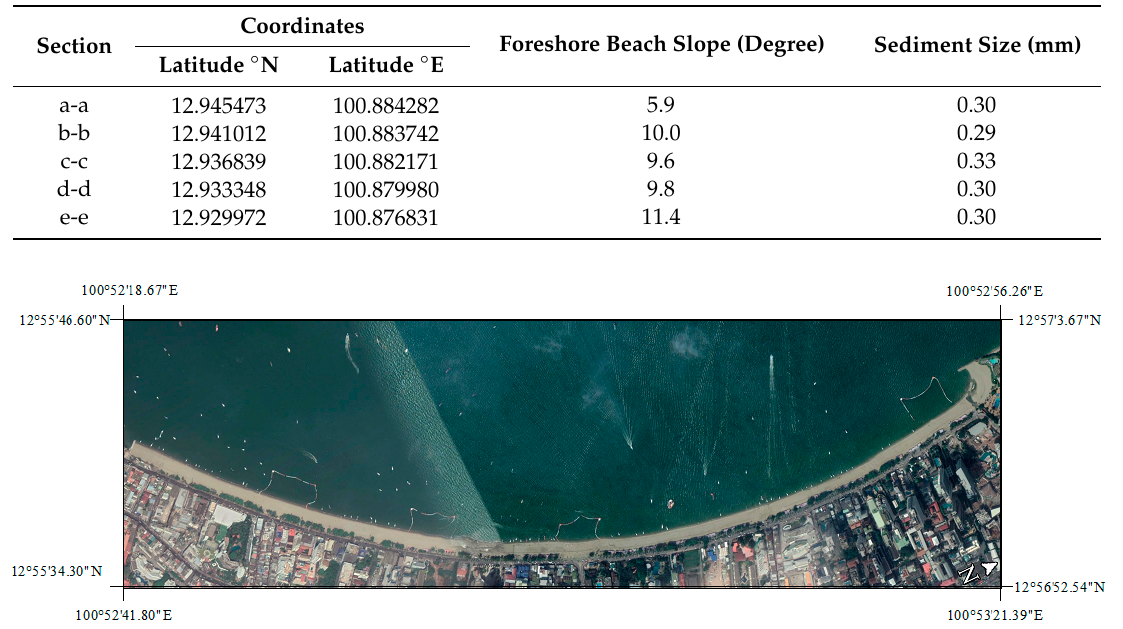
Table 2. Slope, sediment size of Pattaya beach.